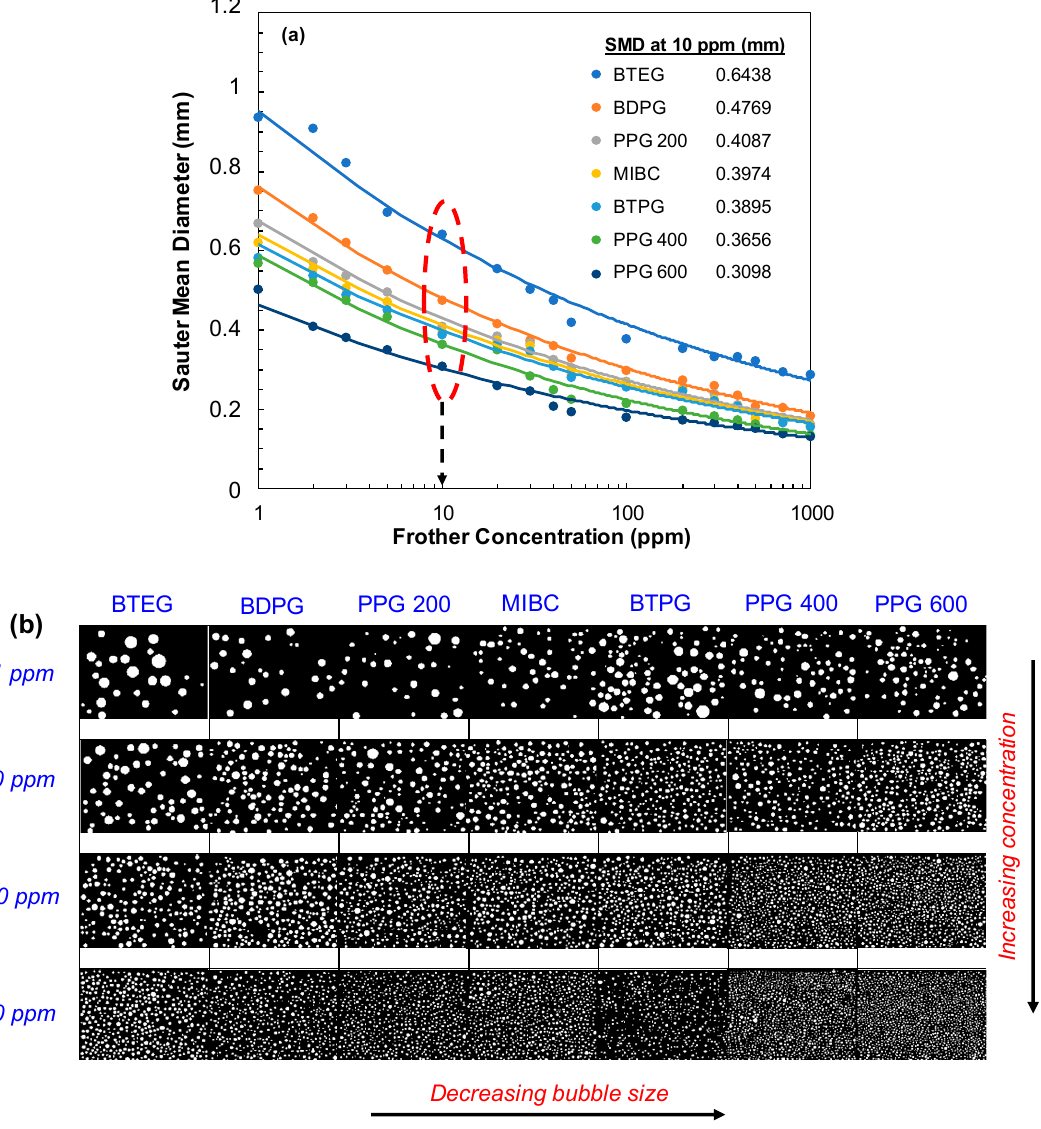
Figure 3 . ( a ) Effect of frother concentration on the SMD of bubbles (Frit pore size: 10–16 μ m, air flowrate: 50 cm 3 /min) ( b ) Images of bubbles as a function of concentration.